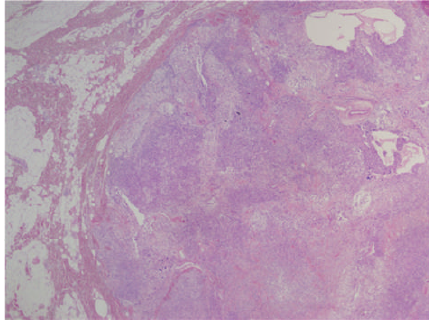
Figure 1: Well circumscribed subcutaneous tumor mass (HE, × 40).